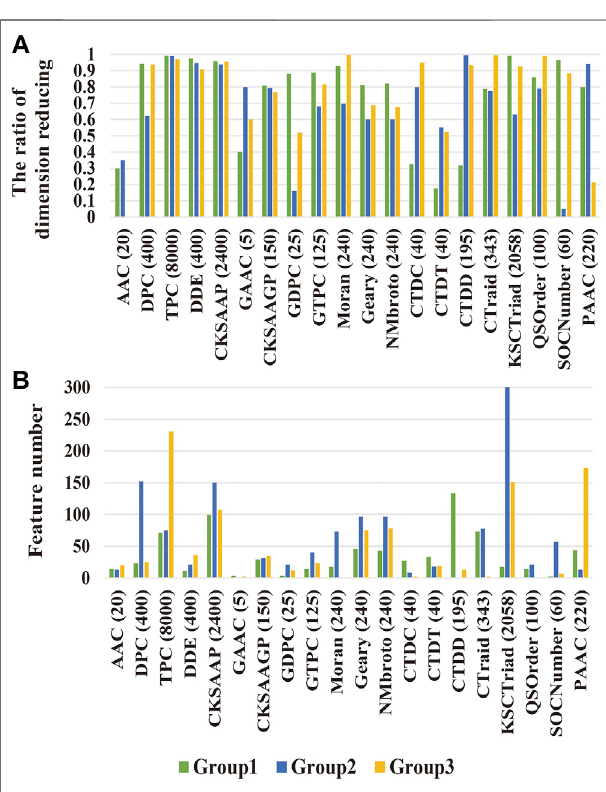
FIGURE 4 | Analysis of MEMD2.0 dimensionality reduction results. (A) The reduced ratio and (B) the number of features in the dimension of three sub-datasets.Thenumbersinparenthesesaretheoriginalfeaturenumbersof various feature extraction